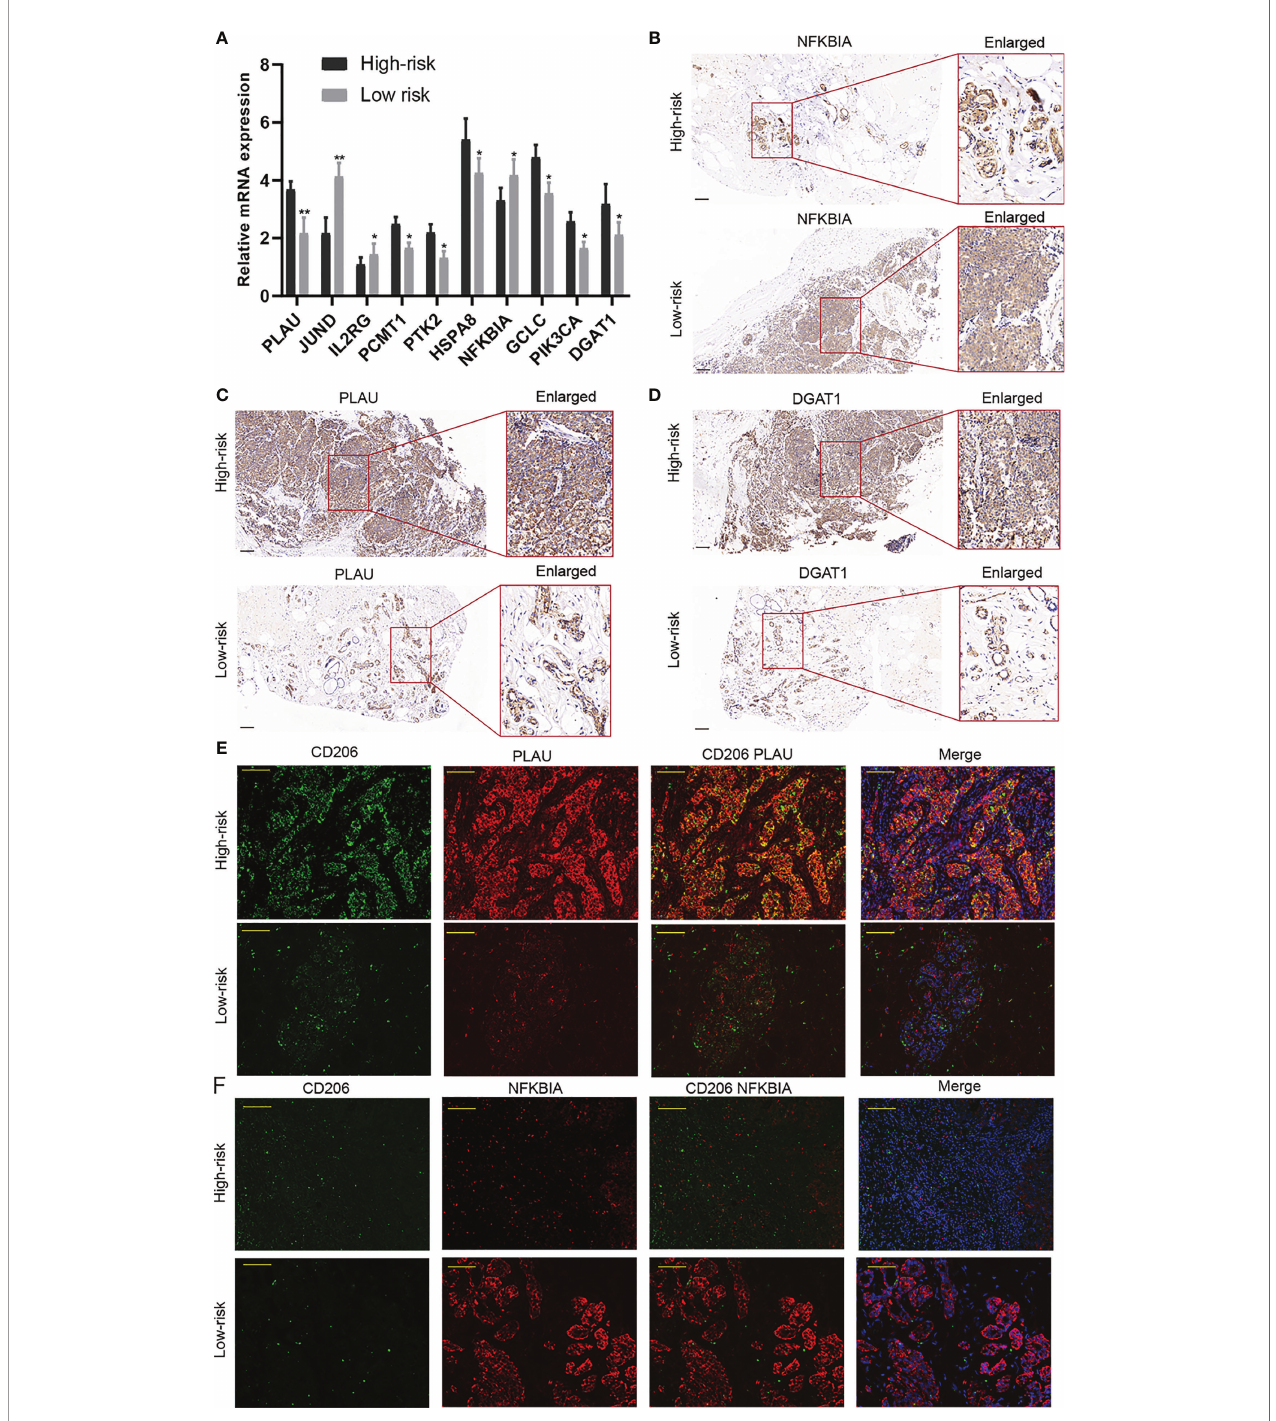
FIGURE 11 | Validation of the predictive ability of the risk model in a clinical external cohort. (A) The relative expressions of the 10 aging-related genes (AGs) in our risk model were assessed in a clinical external cohort through qRT-PCR. (B – D) The results of immunohistochemistry (IHC) revealed that the expressions of PLAU and DGAT1 were increased but NFKBIA expression was decreased in the high-risk group. (E, F) The immuno fl uorescence (IF) assay demonstrated that M2 macrophages were more abundant in high-risk patients. *P < 0.05; **P <